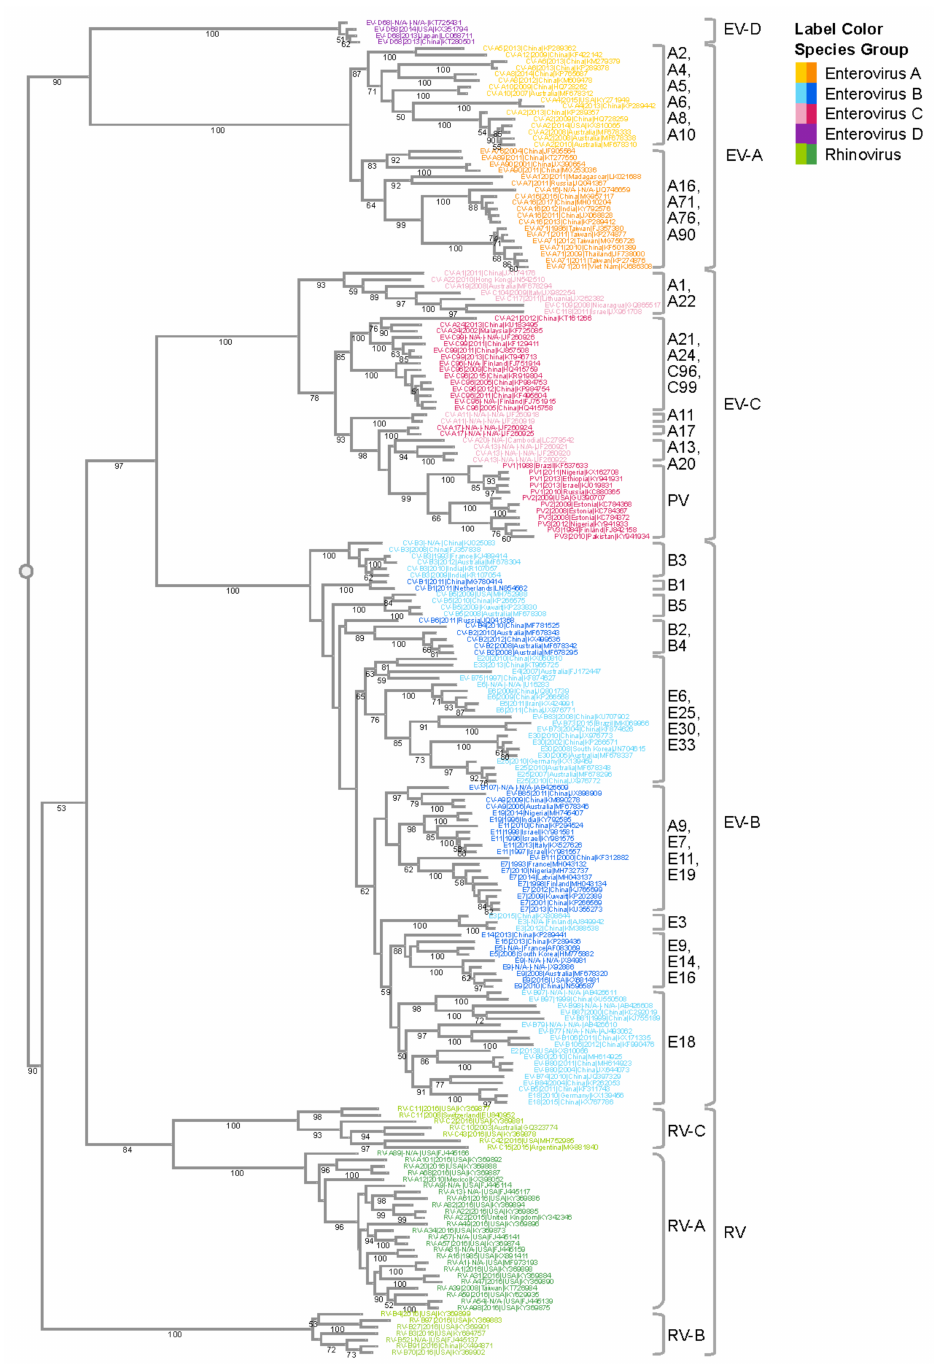
Figure 1. Phylogenetic analysis of the enterovirus genus. VP1 gene sequences from complete human enterovirus genomes were retrieved from the ViPR database (https: // www.viprbrc.org / ). Sequences representative of the genomic diversity were selected using CD-HIT [128], with a threshold of 0.90, and subsequently aligned using MAFFT E-INS-i. The phylogenetic tree was generated using RaXML with 100 bootstrap replicates, and then visualized in Archaeopteryx.js on ViPR with leaf nodes color coded by phylogenetic relatedness. Bootstrap support values of 50 or larger are shown in the tree. Major monophyletic groups are labeled with the major types in the group. Major types are defined as those with 50 or more genomes in the case of EV-A and EV-C, and 200 or more genomes in the case of